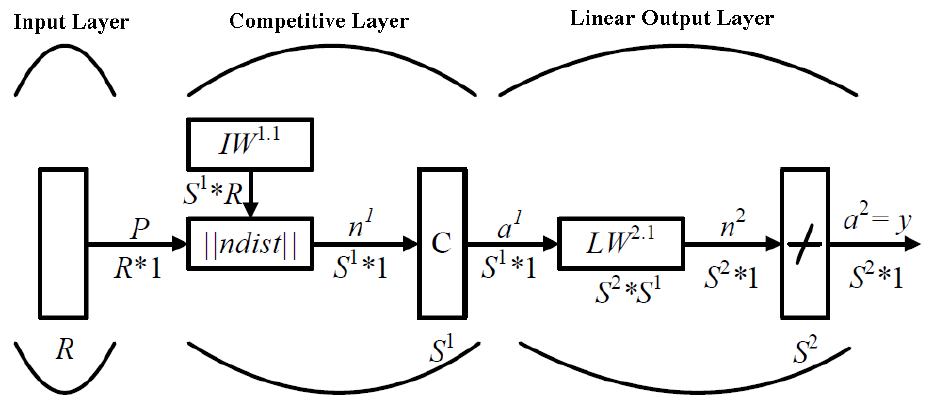
Figure 6. Architecture of LVQ neural